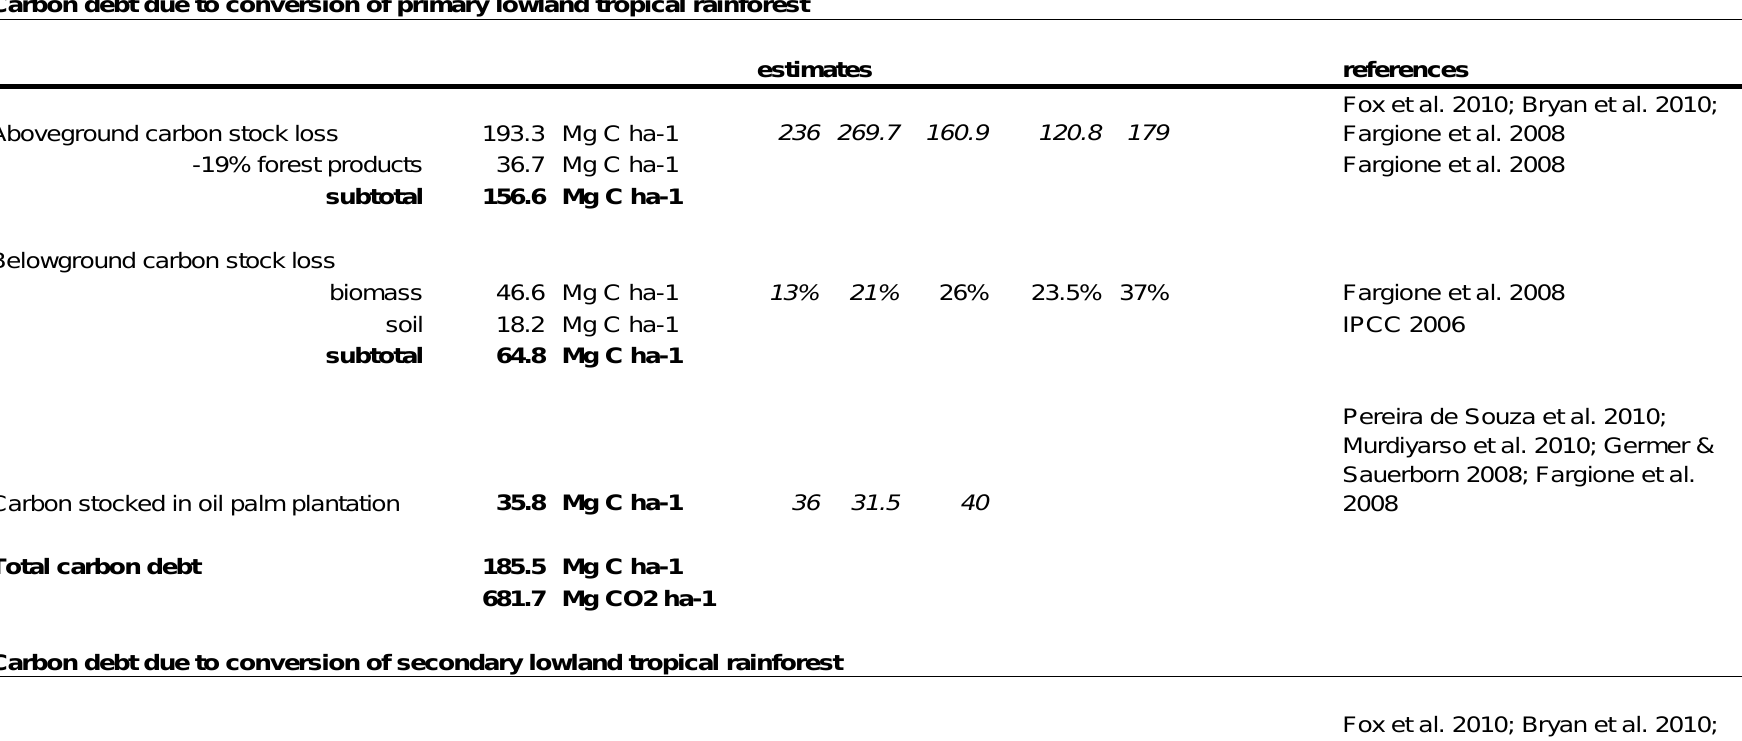
Table A2.1. Carbon debt calculation of the Manokwari, Indonesia